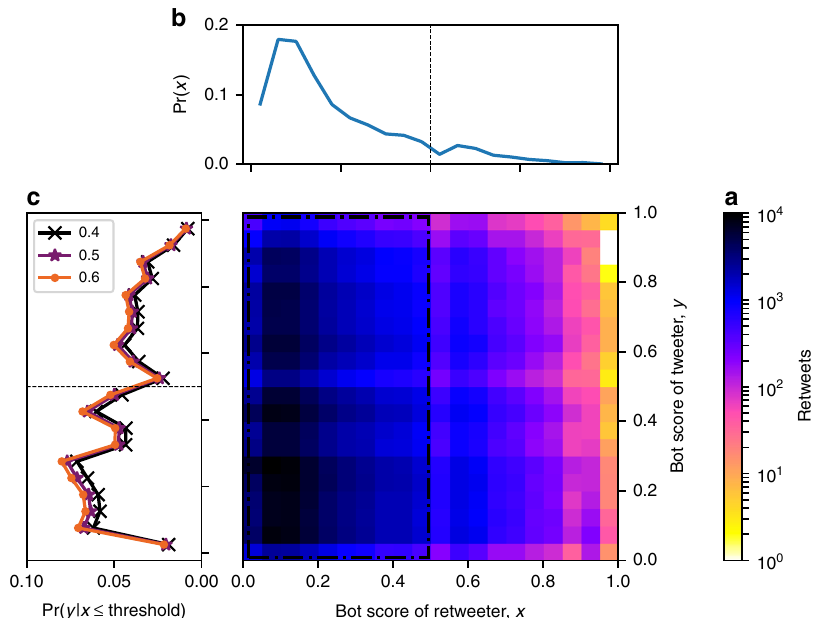
Fig. 4 Impact of bots on humans. a Joint distribution of bot scores of accounts that retweeted links to low-credibility articles and accounts that had originally posted the links. Color represents the number of retweeted messages in each bin, on a log scale. b The top projection shows the distribution of bot scores for retweeters, who are mostly human. c The left projection shows the distribution of bot scores for accounts retweeted by likely humans who are identi fi ed by scores below a threshold of 0.4 (black crosses), 0.5 (purple stars), or 0.6 (orange circles). Irrespective of the threshold, we observe a signi fi cant portion of likely bots retweeted by likely